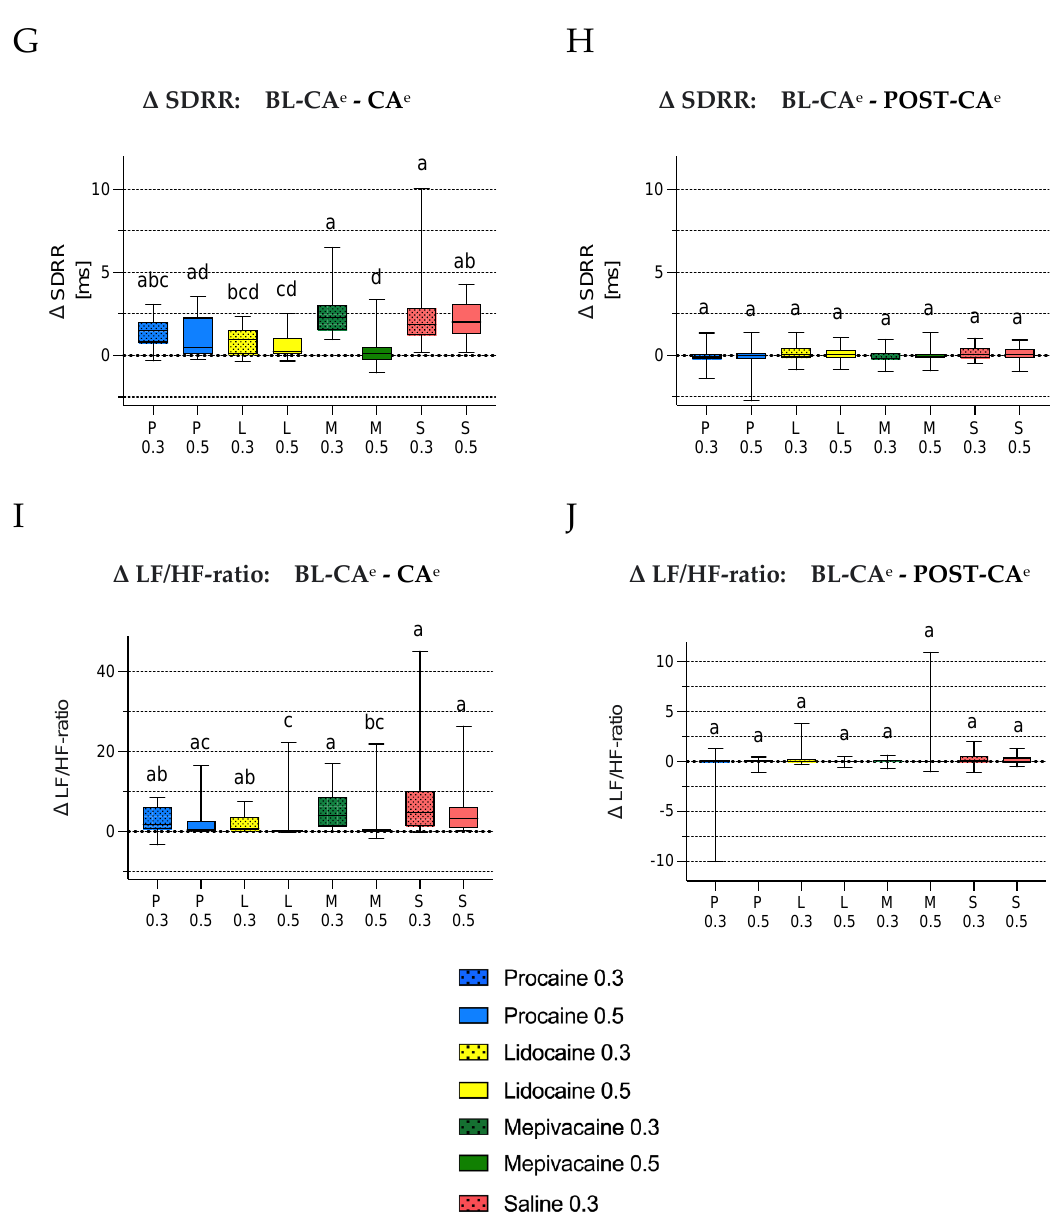
Figure 8. ( A - J ) Mean difference in heart rate, RR-Interval, SDHR, SDRR and LF/HF-ratio between baseline and during castration and between baseline and post castration in the experimental groups. Bar diagrams of ( A ) mean difference in heart rate [beats minute −1 ] between baseline and during castration and ( B ) between baseline and post castration as well as bar diagrams of ( C ) mean difference in RR-Interval [ms] between baseline and during castration and ( D ) between baseline and post castration. The bar indicates the mean is displayed as the top of the bar and standard deviation is represented by the whiskers. Boxplots of ( E ) difference in standard deviation of heart rate (SDHR) [beats minute −1 ] between baseline and during castration and ( F ) between baseline and post castration, ( G ) difference in standard deviation of RR-Interval (SDRR) [ms] between baseline and during castration and ( H ) between baseline and post castration and ( I ) difference in low frequency/high frequency (LF/HF) ratio between baseline and during castration and ( J ) between baseline and post castration. The boxes represent the first and third quartile and the whiskers range from minimum to maximum. The median is indicated by the band inside the box. Different letters (a, b, c, d) show significant differences between the experimental groups ( p < 0.05). The superscript “ e” differentiates time periods/episodes( “ e ” ) from time points (MAP and respiratory rate)